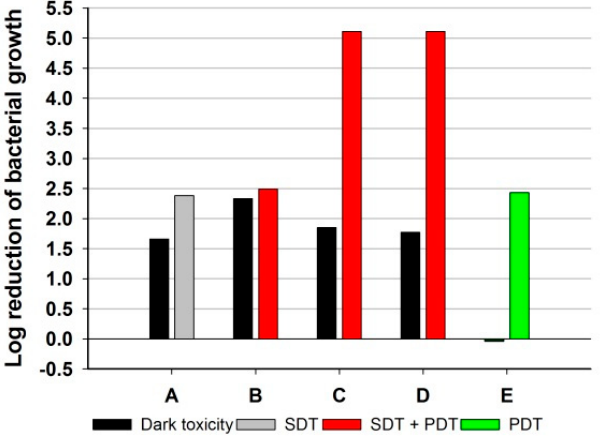
Figure 5. RB and Ce6 synergy evaluation results (A—only RB at 1.0 × 10 − 6 M was subjected to ultrasound only; B—RB at 7.5 × 10 − 7 M and Ce6 at 2.5 × 10 − 7 M, C—RB at 5.0 × 10 − 7 M and Ce6 at 5.0 × 10 − 7 M, D—RB at 2.5 × 10 − 7 M and Ce6 at 7.5 × 10 − 7 M were subjected to ultrasounds and further